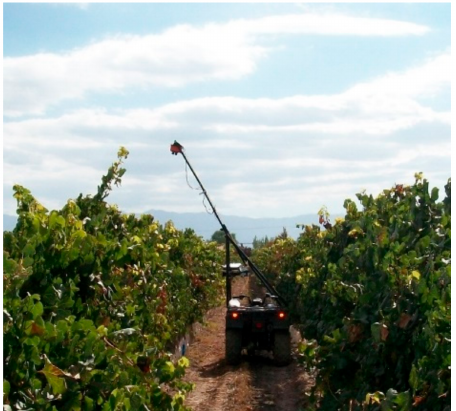
Figure 2. Image collection arrangement. The Tetracam system mounted on a boom and placed in a nadir viewing position over the canopy at each sampling